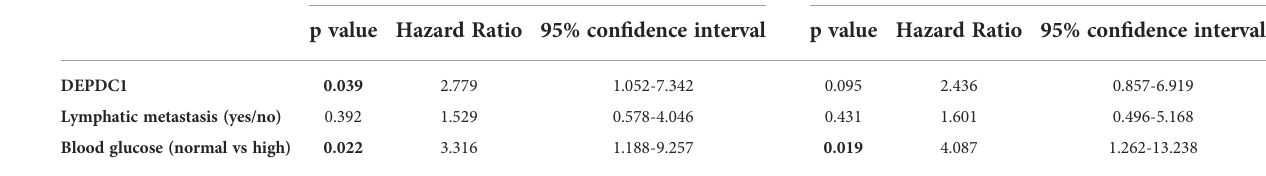
TABLE 4 Univariate and multivariate analyses of various prognostic parameters in patients with OSCC Cox-regression analysis. Univariate analysis Multivariate